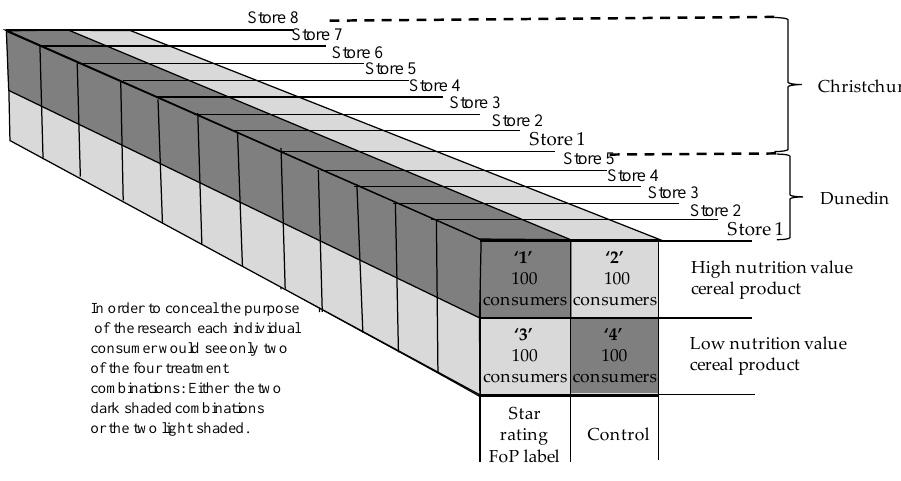
Figure 5. Experimental design.